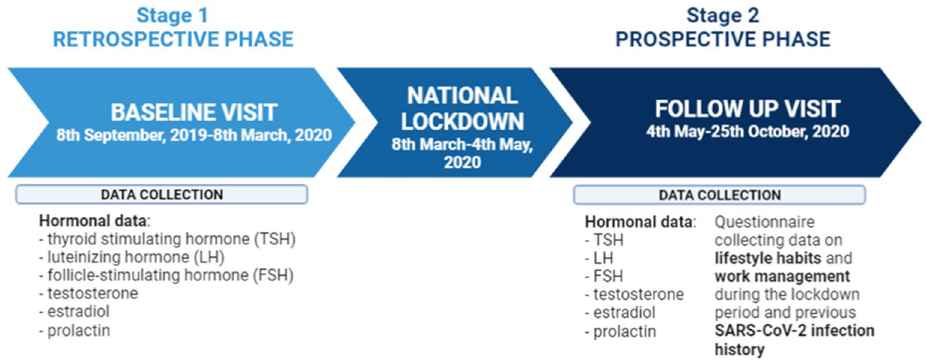
Figure 1. Flow-chart of the study. SARS-CoV-2 = severe acute respiratory syndrome